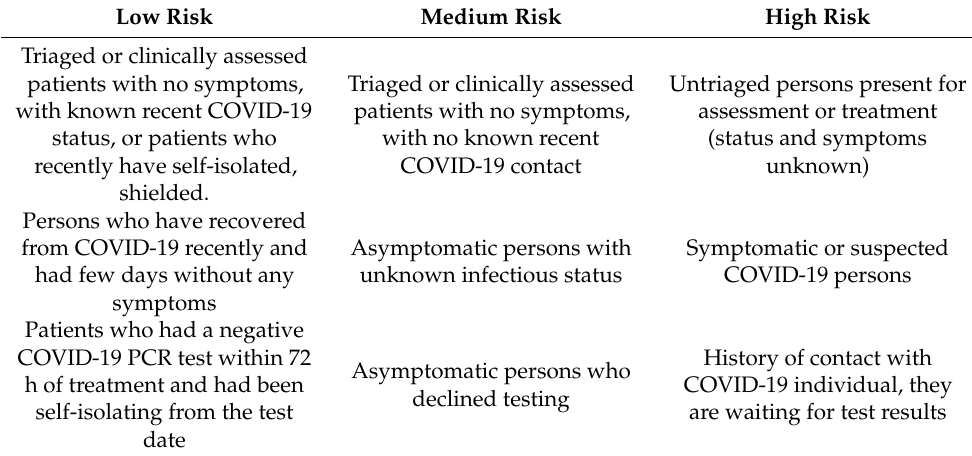
Table 2. COVID-19 risk categories of